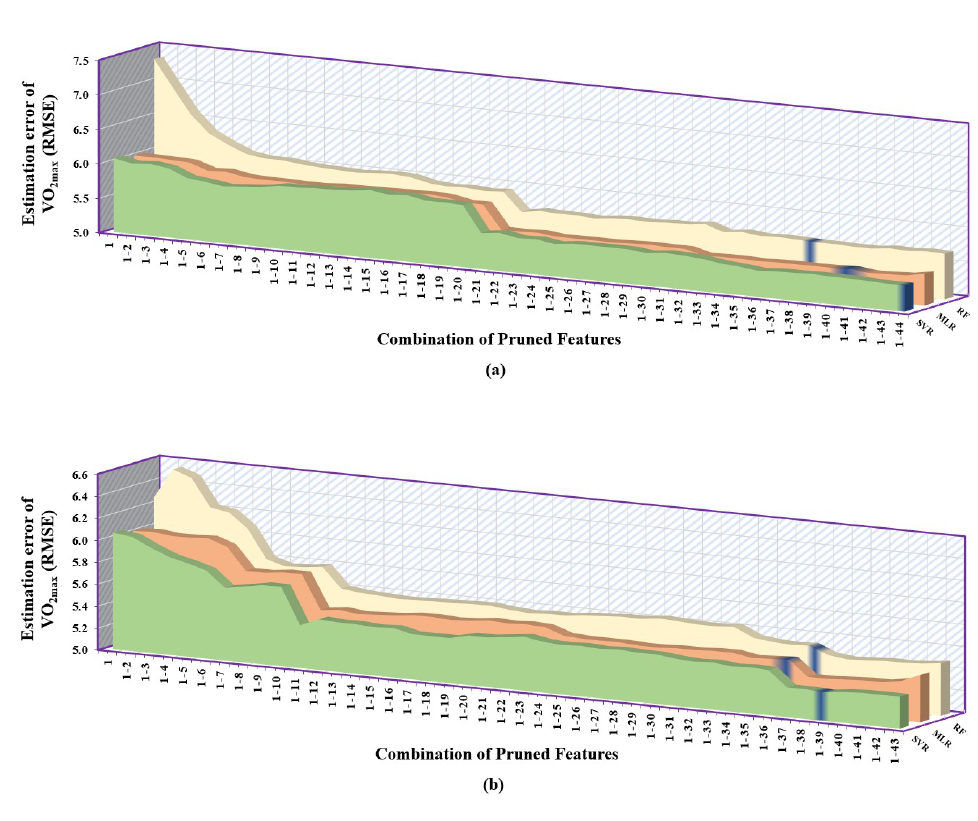
Figure 6. Error plot depicting the performance of regression models (MLR, RF, SVR) trained using a combination of pruned features associated with exercise data. The y–axis of each subplot shows prediction error using: ( a ) correlation–based feature selection method. ( b ) mutual information–based feature selection method. Each entry in the x–axis is represented in the form [1–N], which corresponds to the combination of 1 st to N th feature set that is provided to regression models.